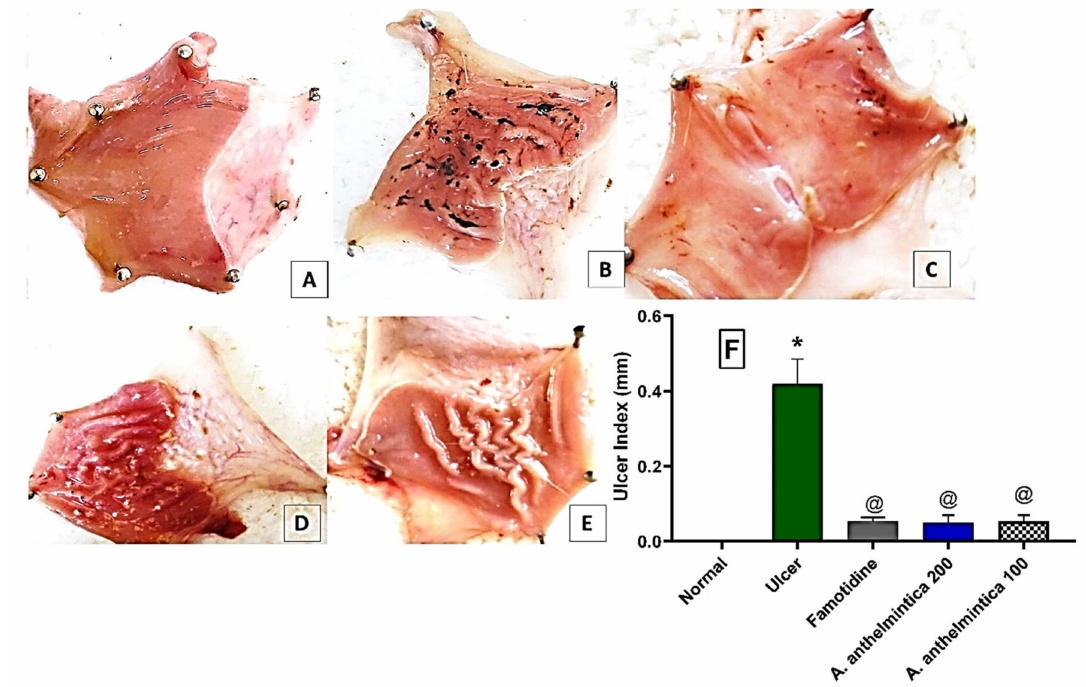
Figure 2. Representative rat stomach photomacrographs that were cut along the greater curvature. ( A ) Control, ( B ) ‘in- domethacin, ( C ) reference drug (famotidine), ( D ) A. anthelmintica extract (200 mg/kg), ( E ) A. anthelmintica extract (100 mg/kg) representing the substantial existence of many circular and linear gastric ulcers in the indomethacin group, which were significantly reduced by the reference drug (famotidine) and the two tested doses of A. anthelmintica extract. ( F ) The effects of indomethacin without or with pre-treatments of famotidine, and the tested extract ( A. anthelmintica , 200, 100 mg/kg) on the gastric ulcer index in rats. Statistical analyses were carried out utilizing one-way ANOVA followed by Tukey’s post hoc test, n = 5–6, mean ± SEM. * Significantly different from control group at p < 0.05. @ Significantly different from indomethacin alone (ulcer) group at p <